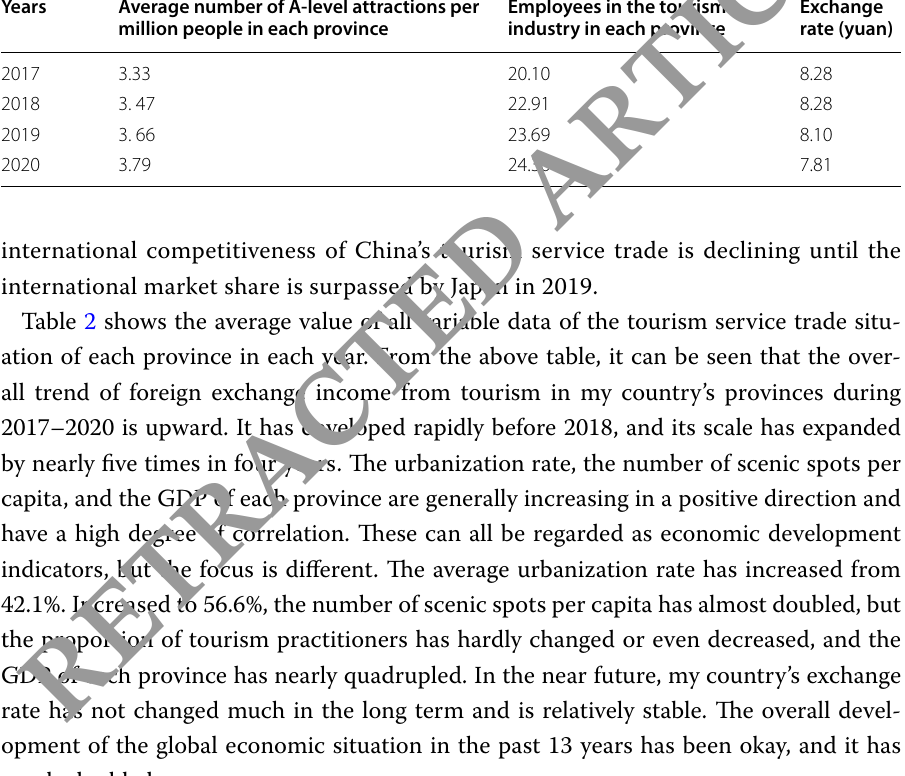
Table 2 The mean value of all variable data of each province’s tourism service trade situation in each year Years Average number of A‑level attractions per million people in each province